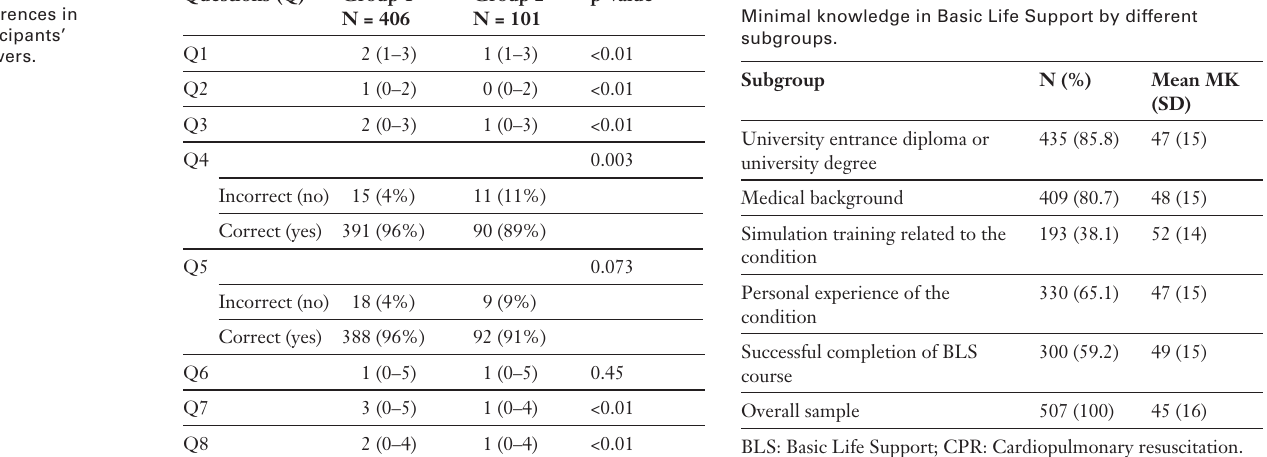
Minimal knowledge in Basic Life Support by different